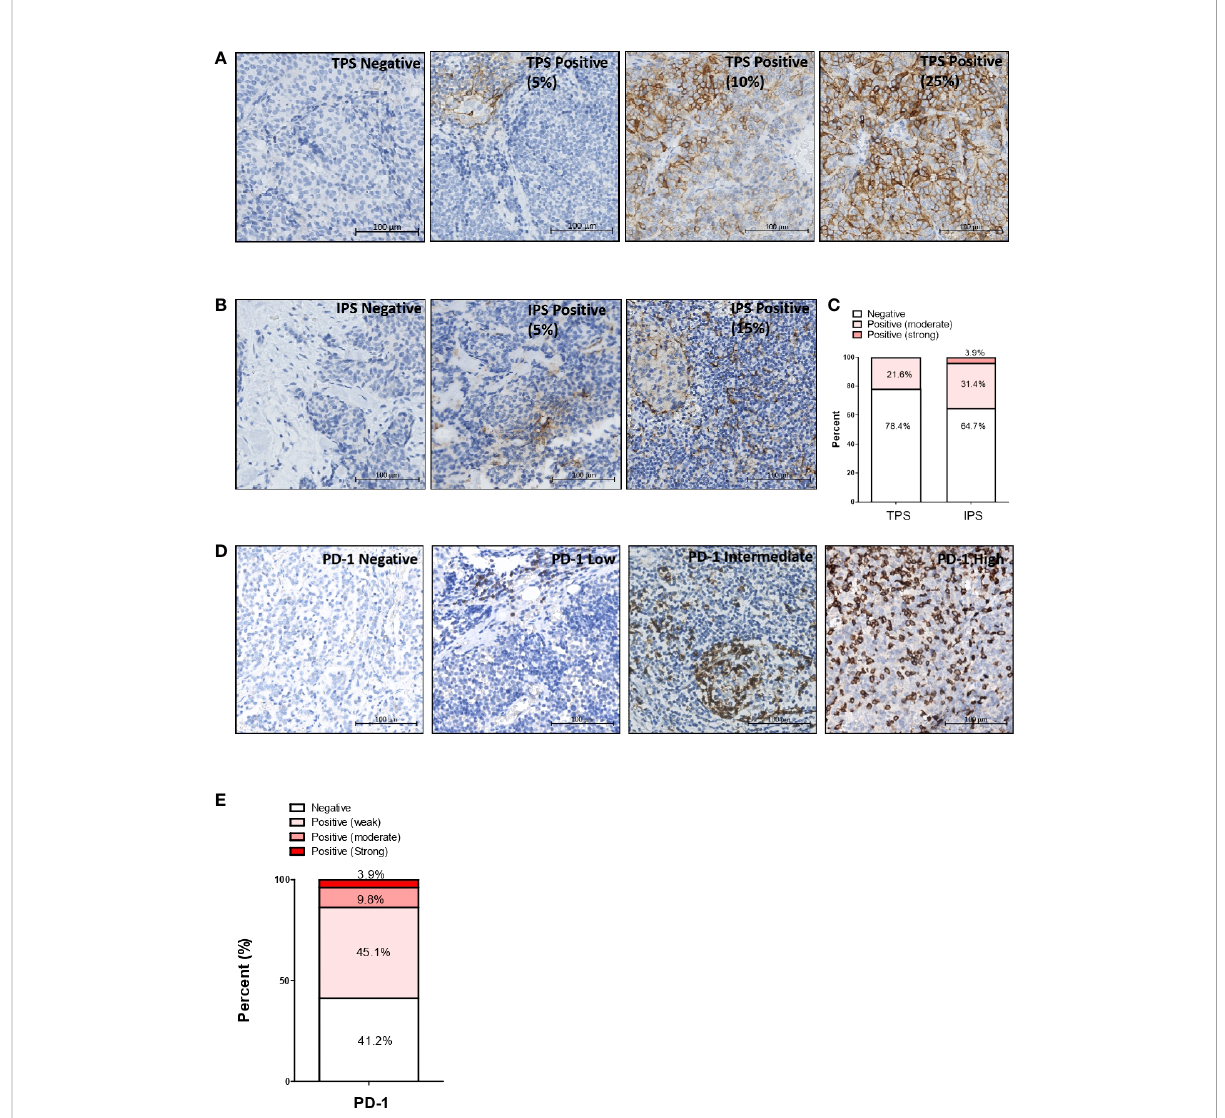
FIGURE 1 Expression pattern of immune checkpoint markers PD-L1 and PD-1 in T-NEN. Representative PD-L1 IHC staining images of T-NEN are showed. (A) Different levels of PD-L1 staining (brown) on tumor cells are showed. (B) Different levels of staining (brown) on immune cells are showed. (C) Proportion of strati fi ed PD-L1 intensity according to TPS and IPS evaluation is displayed. (D) Different in fi ltration levels of PD-1-positive cells are shown with representative IHC staining images. (E) Proportion of strati fi ed PD-1 intensity in T-NEN is displayed. Remark: Representative IHC staining images are shown in an area of 0.09 mm 2 (0.3 mm×0.3 mm) captured from each